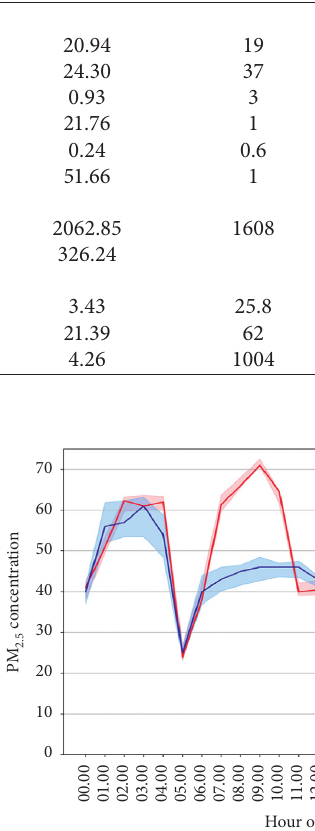
Figure 15: PM 2.5 concentration of vehicle emissions on the Fourth Ring